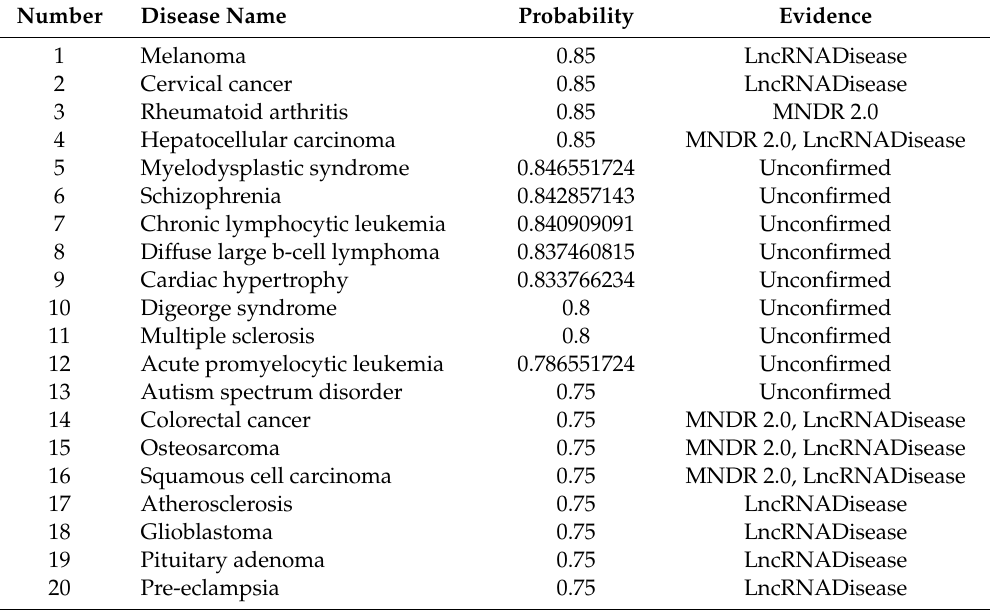
Figure 7. Comparison with different feature for lncRNA-disease association prediction. ( a ) The five-fold cross-validation performance using only the attribute feature; ( b ) the five-fold cross-validation performance using the Gaussian profile kernel similarity feature; ( c ) the five-fold cross-validation performance using only the behavior feature generated by LINE using other eight associations in the whole MAN and training data in lncRNA-disease data; and ( d ) the five-fold cross-validation performance using behavior feature generated by LINE using other eight associations in the whole MAN. Table 6. Top-20 prediction verified in the lncRNADisease and MNDR 2.0